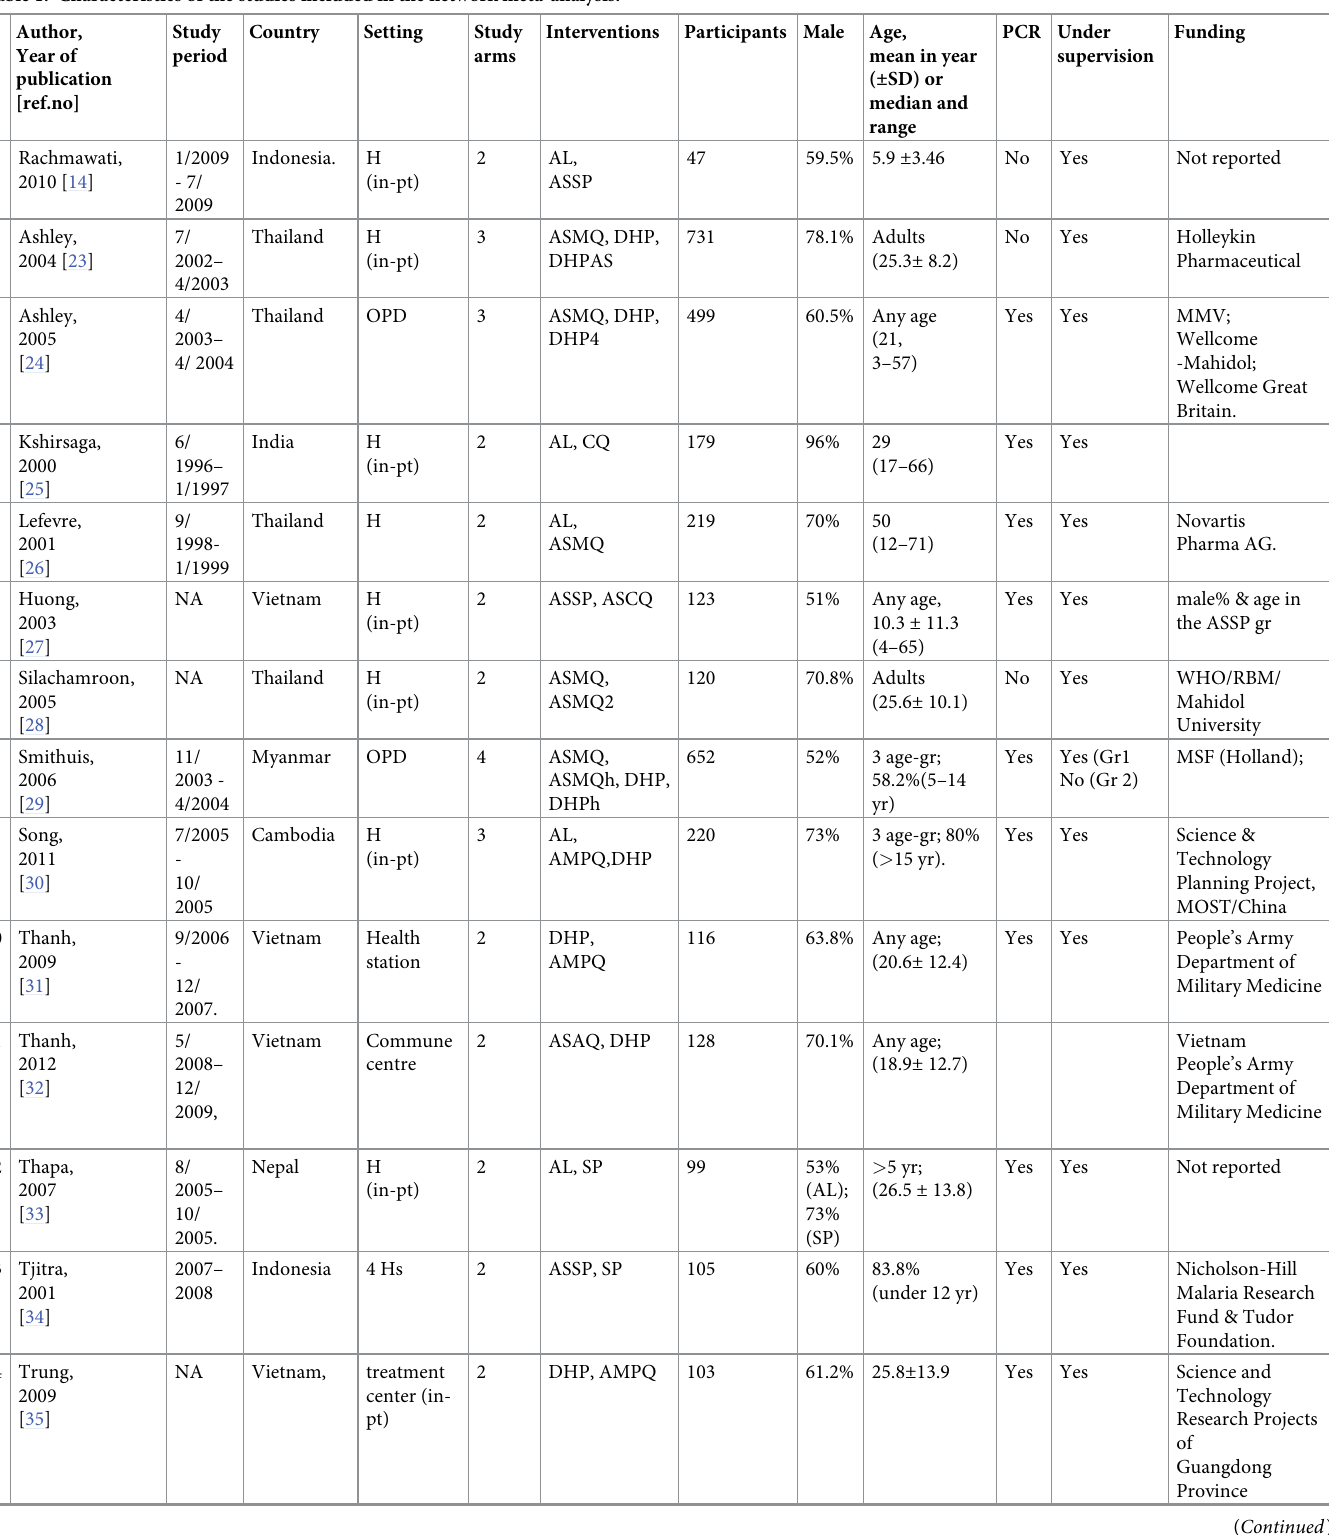
Table 1. Characteristics of the studies included in the network